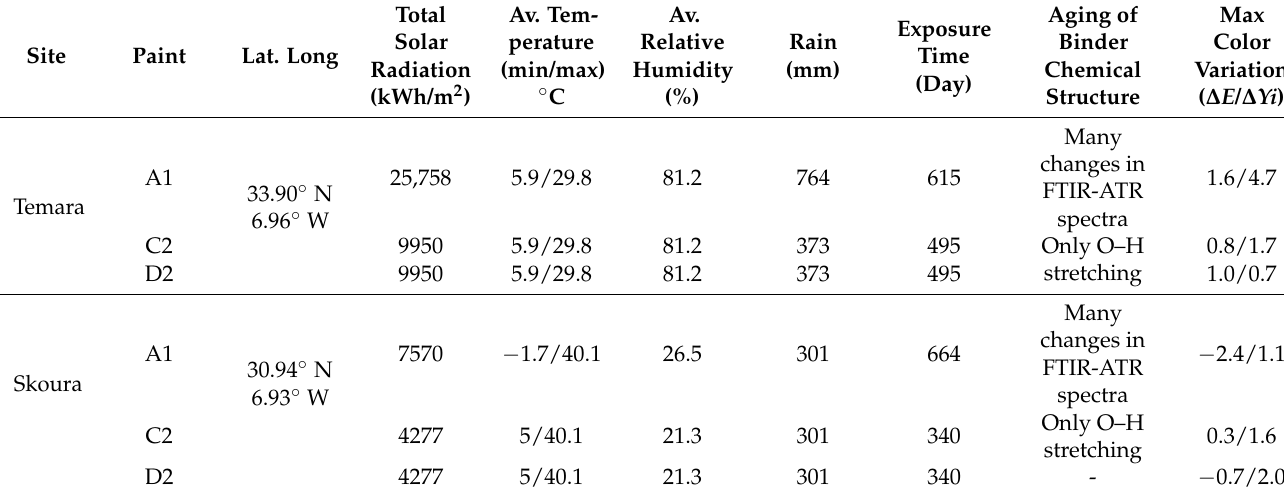
Table 8. Summary of the main parameters and results of durability outdoor tests conducted on paints A1, C2, and D2.